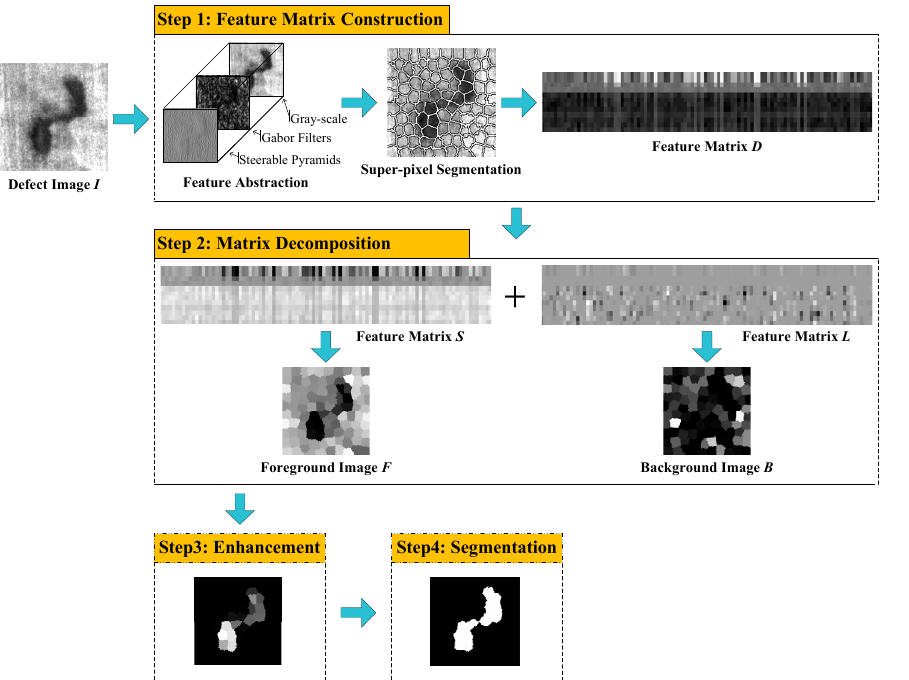
Figure 2. Diagram of the proposed double low-rank and sparse decomposition (DLRSD)-based segmentation method for surface defect image. segmentation method for surface defect